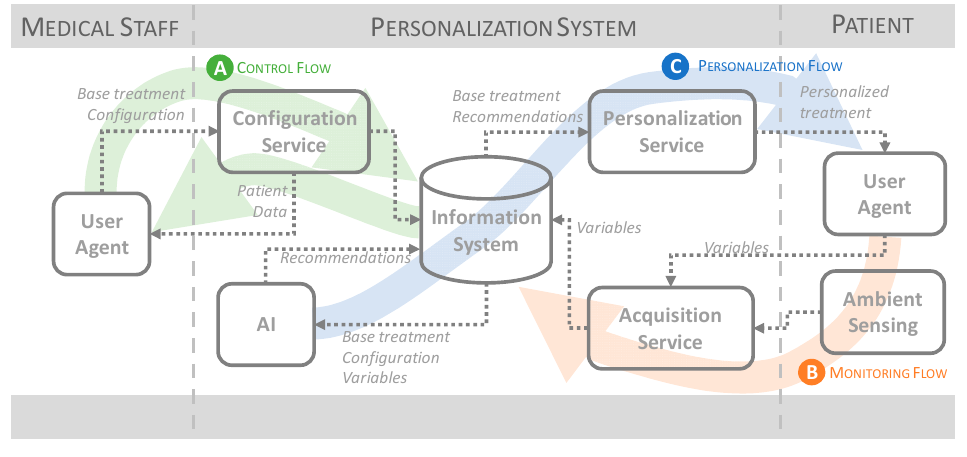
Figure 2. Proposed model.